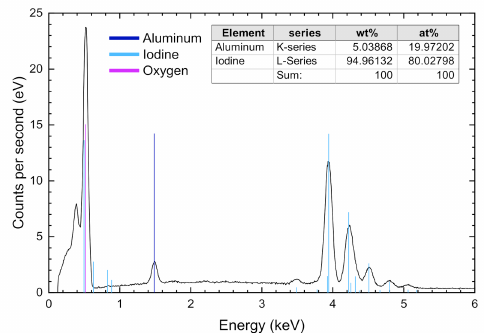
Figure 1. EDX elementary analysis of LiAl(IO 3 ) 4 . No traces of impurities were found in our